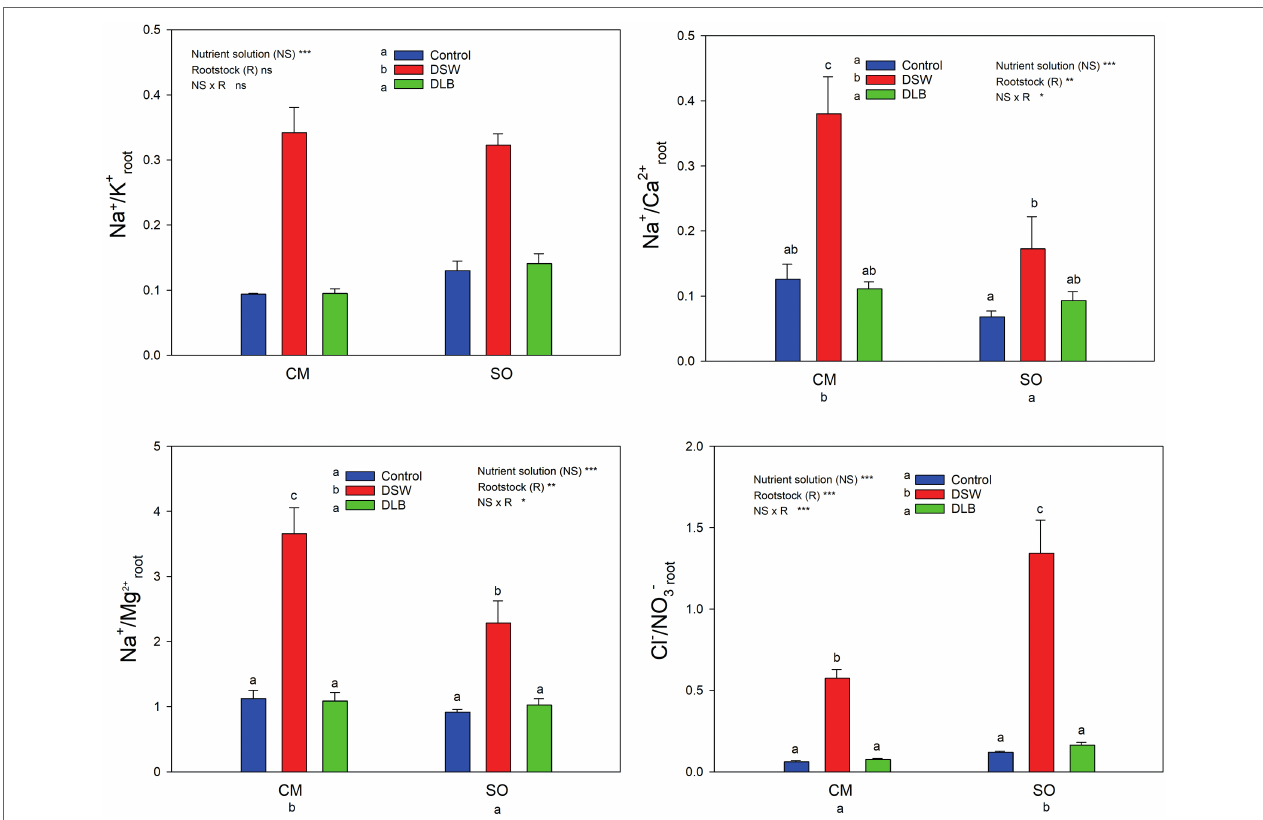
FIGURE 6 | Effects of 7 months of irrigation with nutrient solutions of different characteristics—Control, DSW, and DLB—on different ratios of ionic concentrations (Na + or Cl − and essential nutrients) in roots of ‘Verna’ lemon plants grown on two rootstocks, Citrus macrophylla (CM) and sour orange (SO). Different letters indicate significant differences according to Duncan’s multiple range test at the 95% confidence